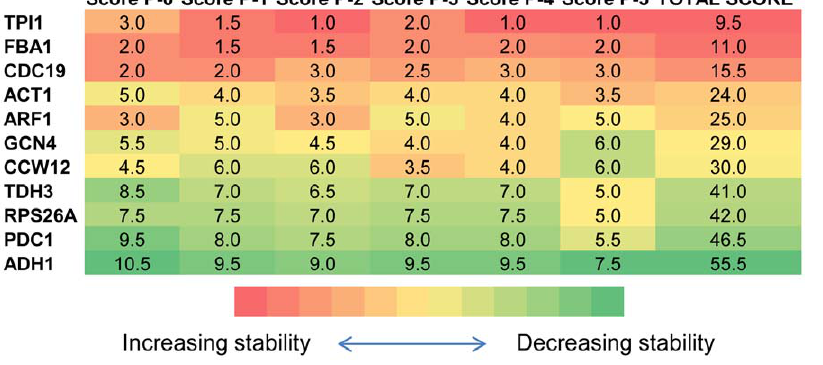
Figure 1. Scoring of the candidate genes in Case Study I. The cells representing the scores of the genes in different pools were colour coded. A coding scale from red to green indicated decreasing stability. The score of the genes in each pool was indicated by the number assigned to that cell in a quantitative manner; the smallest score indicating the most stable gene and the largest score indicating the least stable one. The stability of the gene associated with that score was also indicated by the colour assigned to that cell in a qualitative manner. The scoring of the six different pools of candidate genes was determined as the average ranking for each gene as indicated by the NormFinder and the geNorm analyses and the results were provided in the first six columns. The analysis was carried out using all genes (P-0), and using the 5 pools, each excluding a different set of correlated genes (P-1 to P-5). The total score for each gene was provided in the last column by summing up all of its scores through P-0 to P-5.